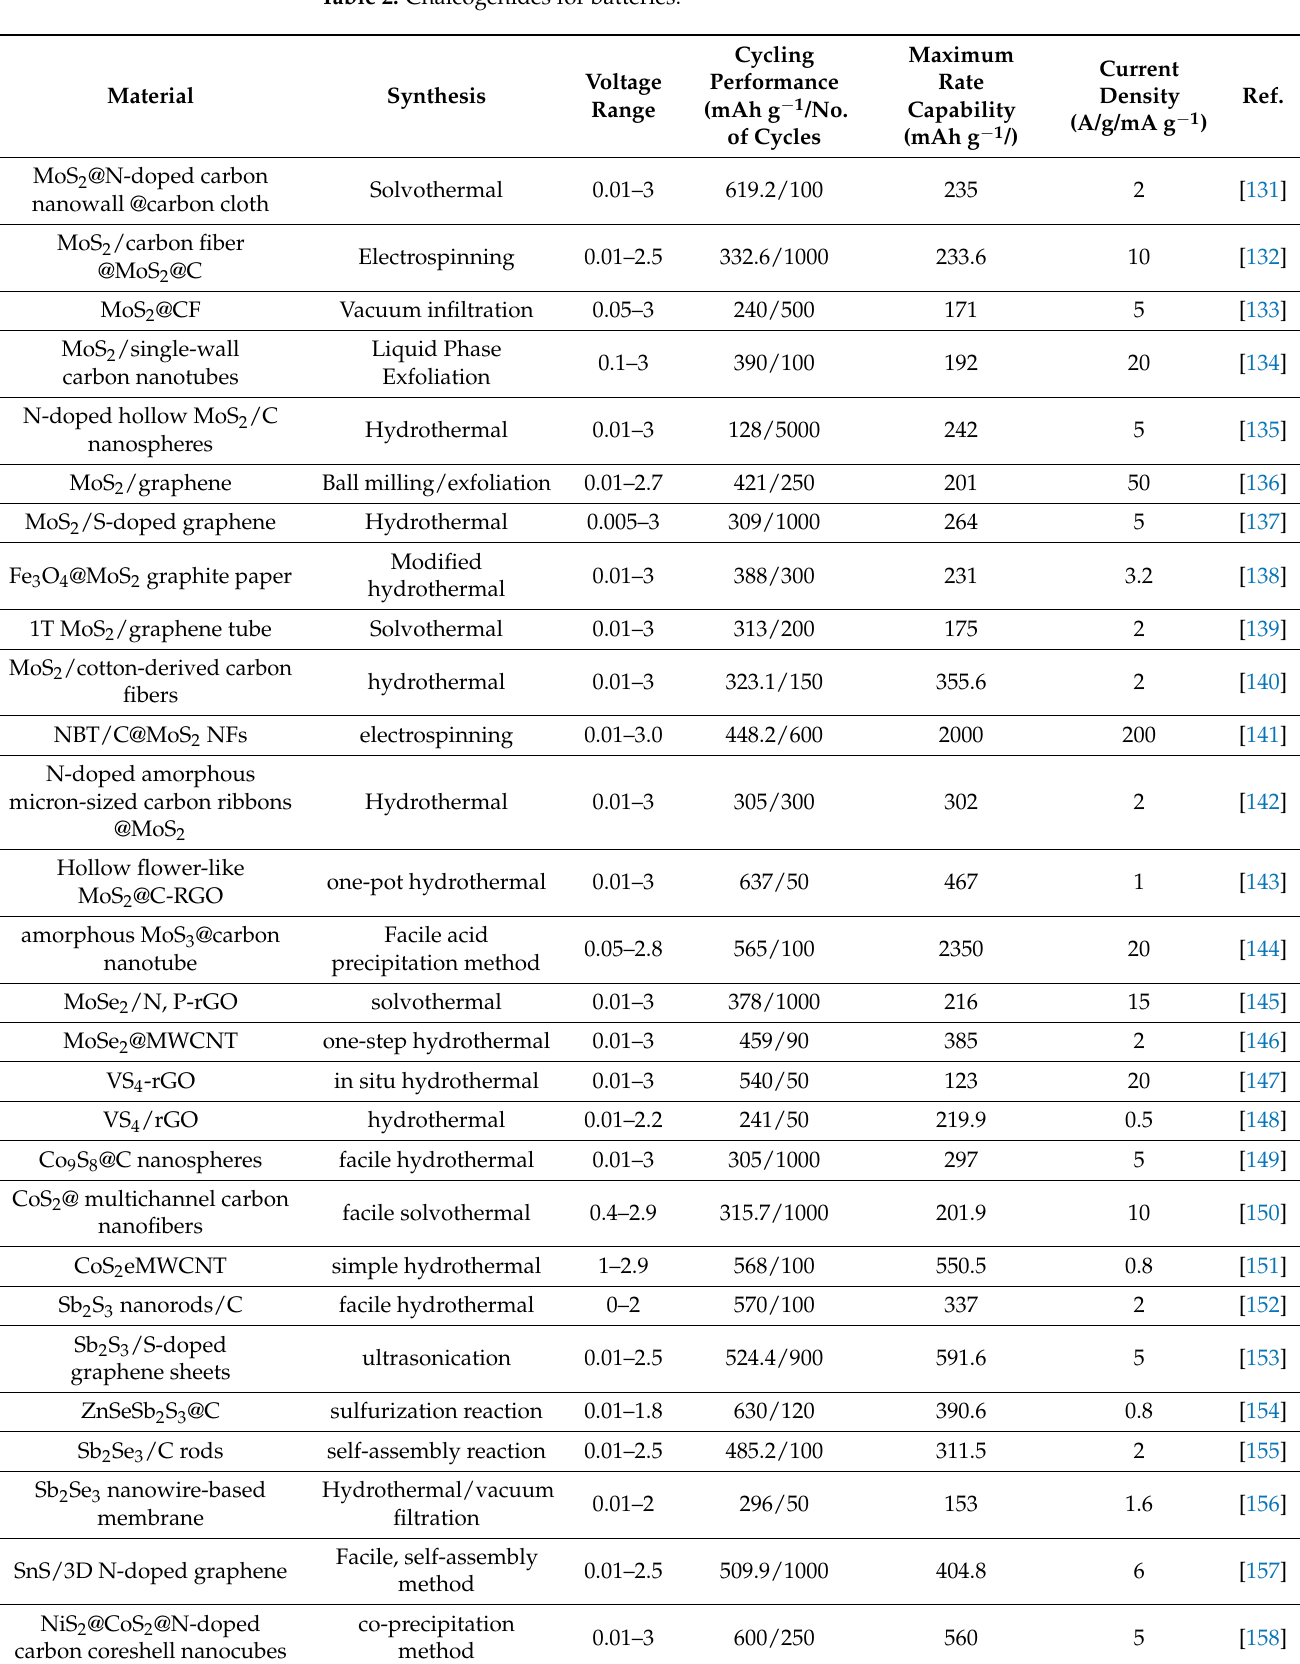
Table 2. Chalcogenides for